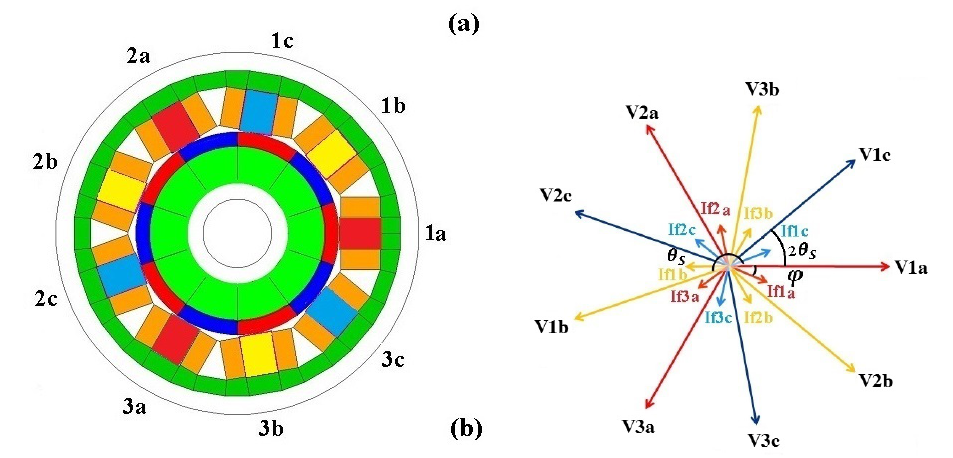
Figure 3. Case III : base machine ( a ) and phasor diagrams ( b ). Red teeth and red star supplied by the converter a , yellow teeth and yellow star supplied by the converter b ; blue teeth and yellow star supplied by the converter c . ϕ is the V-I phase angle and θ S is the electric displacement between two sequential stars.